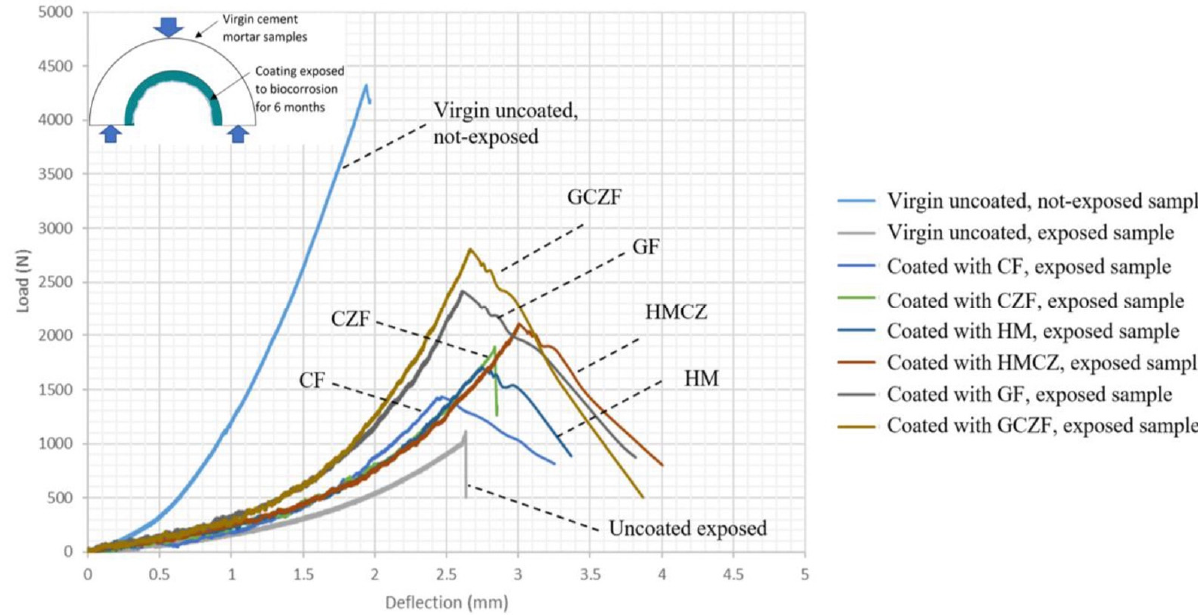
Figure 11. ( a ) arch-shaped samples with applied coatings ( b ) coatings placed on virgin (left) and corroded (right) samples [1].